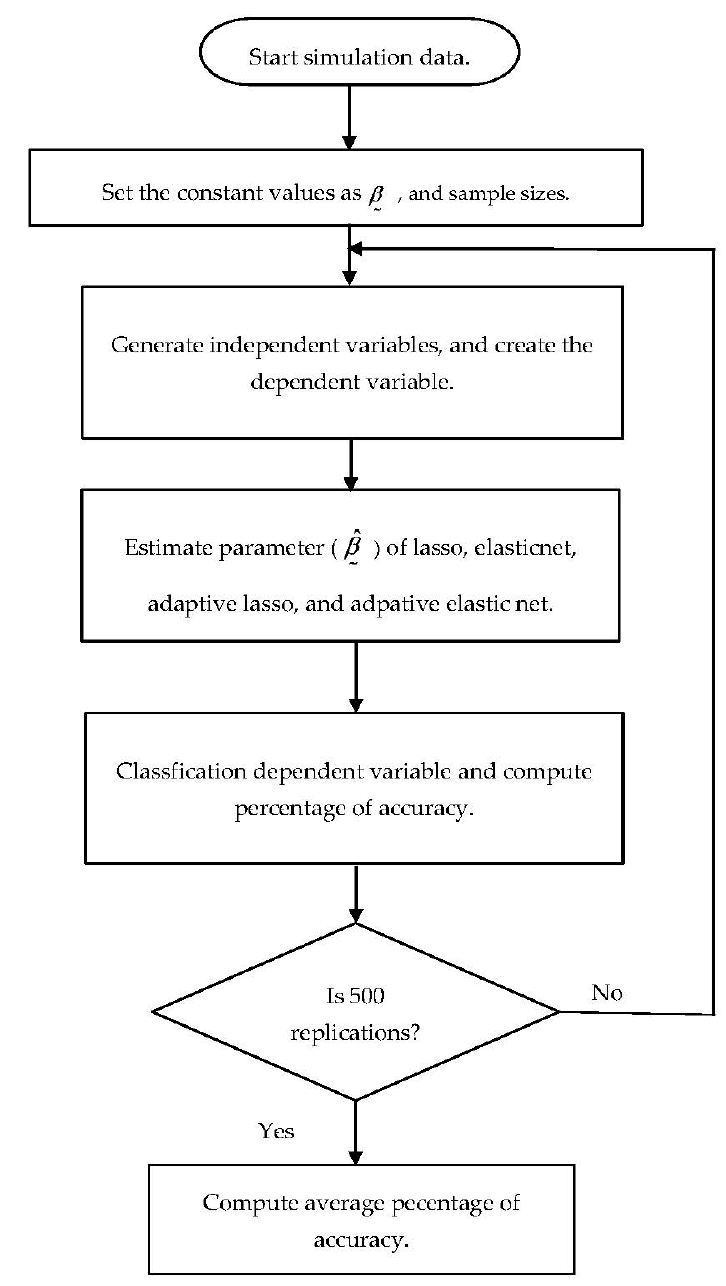
Figure 2. The flowchart diagram of simulation process.